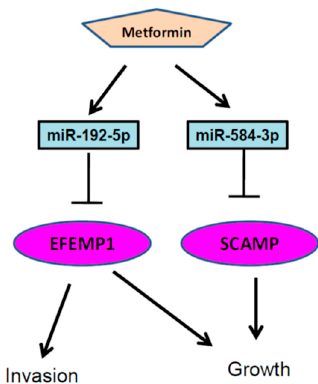
Figure 11. Putative model describing that metformin suppressed melanoma cell growth and motility through modulating the miR-192-5p/EFEMP1 and miR-584-3p/SCAMP3 axes.